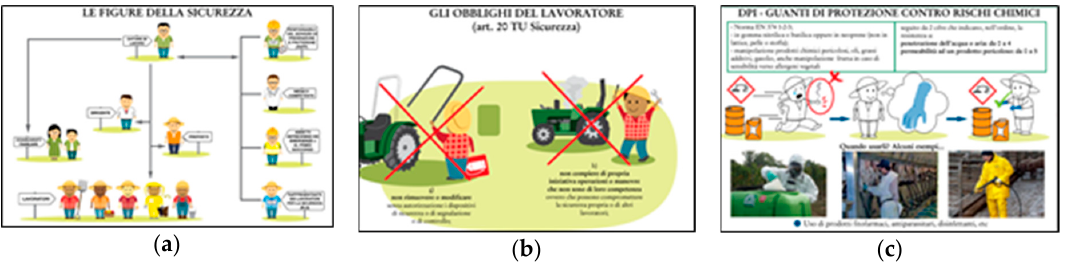
Figure 1. Some of the slides designed for the new training material developed: ( a ) farmworkers’ rights and duties, ( b )identification and roles of members of health and safety management and ( c )use of contrast to highlight some details and the primary role as provided by photographs.